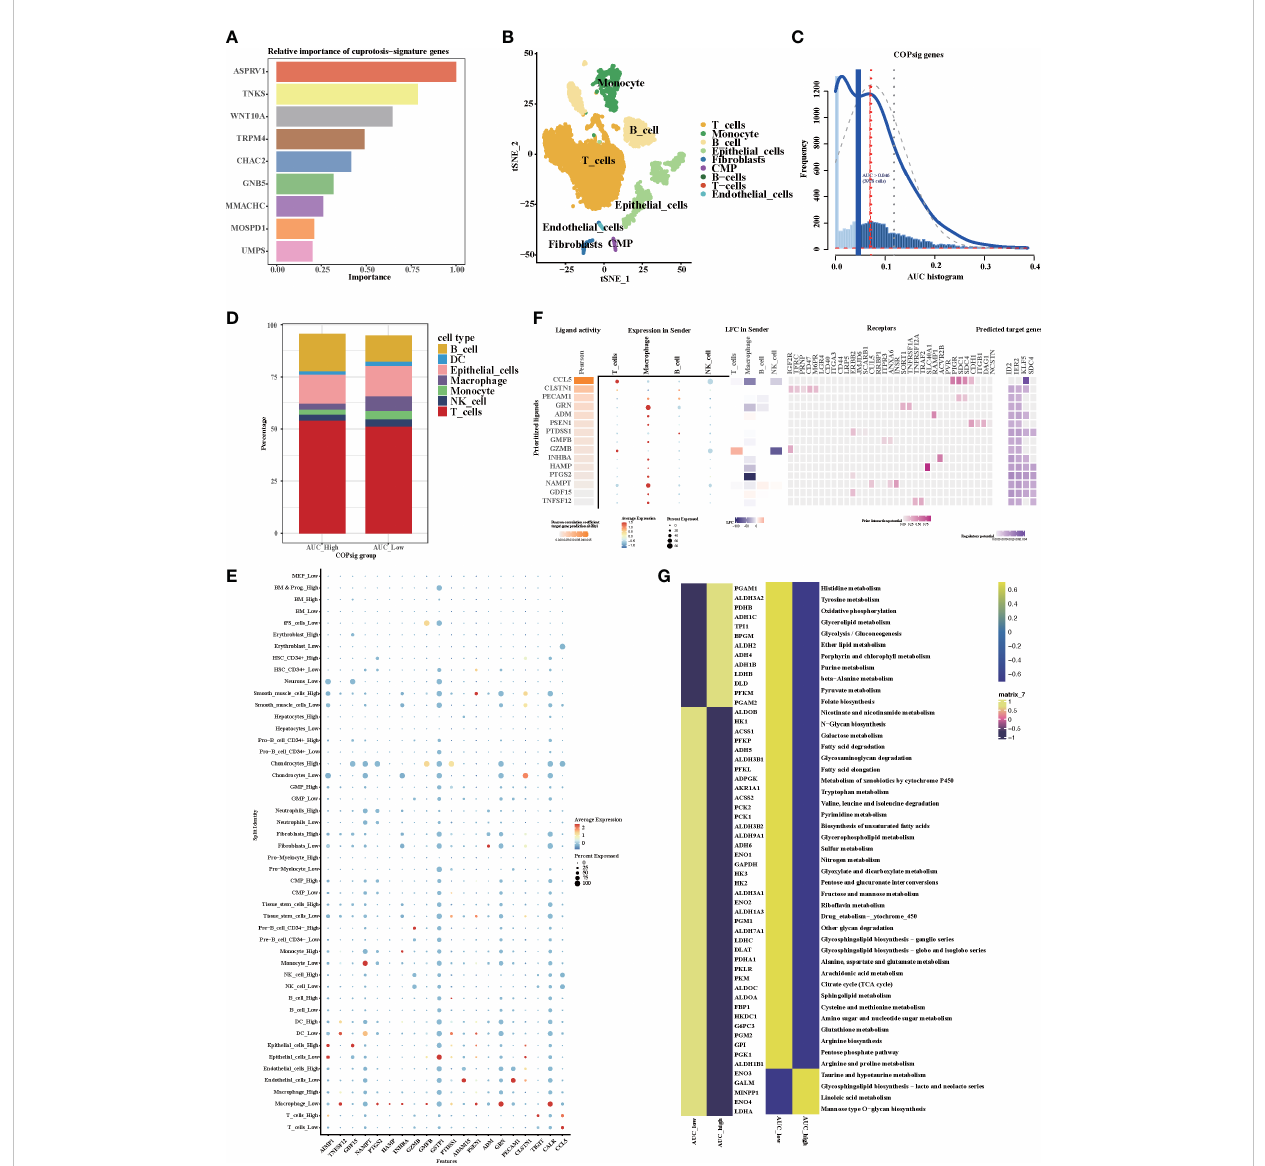
FIGURE 8 The expression of cuprotosis signature genes in TME by single-cell transcriptome analysis. (A) Relative importance of cuprotosis signature genes analyzed by random forest algorithm. (B) The t-SNE (t-distributed stochastic neighbor embedding) plot of 6,490 cells grouped into 12 clusters. (C) The threshold was chosen as 0.046 and the AUCell score of 3,918 cells exceeded the threshold value. (D) Percentage of each distinct cells in the high and low AUCell score groups. (E) Heatmap shows the expression of the top 20 active ligands in cells of the high and low AUCell score groups. The size of the dot represents the percent expressed. Red represents high expression; blue represents low expression. (F) Expression of the fi rst 15 active ligands in different cells, as well as their interacting receptors and downstream potential target genes. (G) Metabolic differences in the high and low AUCell score